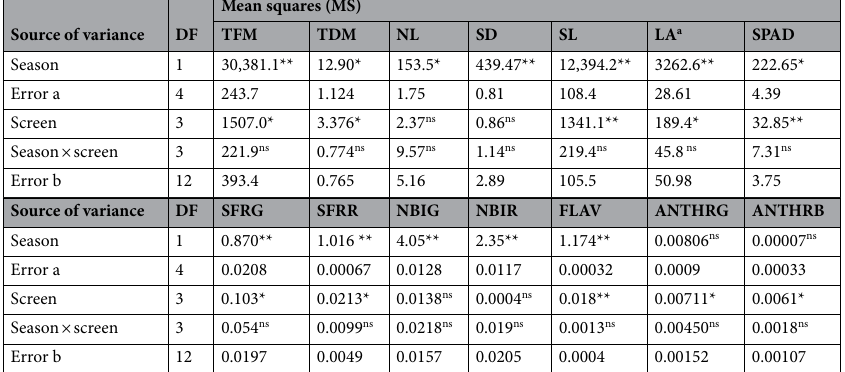
Table 1. Summary of analysis of variance of morphological and physiological characteristics. TFM total fresh matter (g), TDM total dry matter (g), NL number of leaves, SD stem diameter (mm), SL stem length (mm), LA leaf area (cm 2 ). *Significant at 5% of probability (p < 0.05). ** Significant at 1% of probability (p < 0.01); ns no significant. a Values divided by 10 3 .